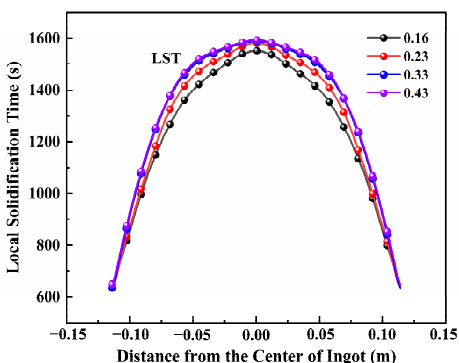
Figure 13. Change of LST along radical direction with varying filling ratio.